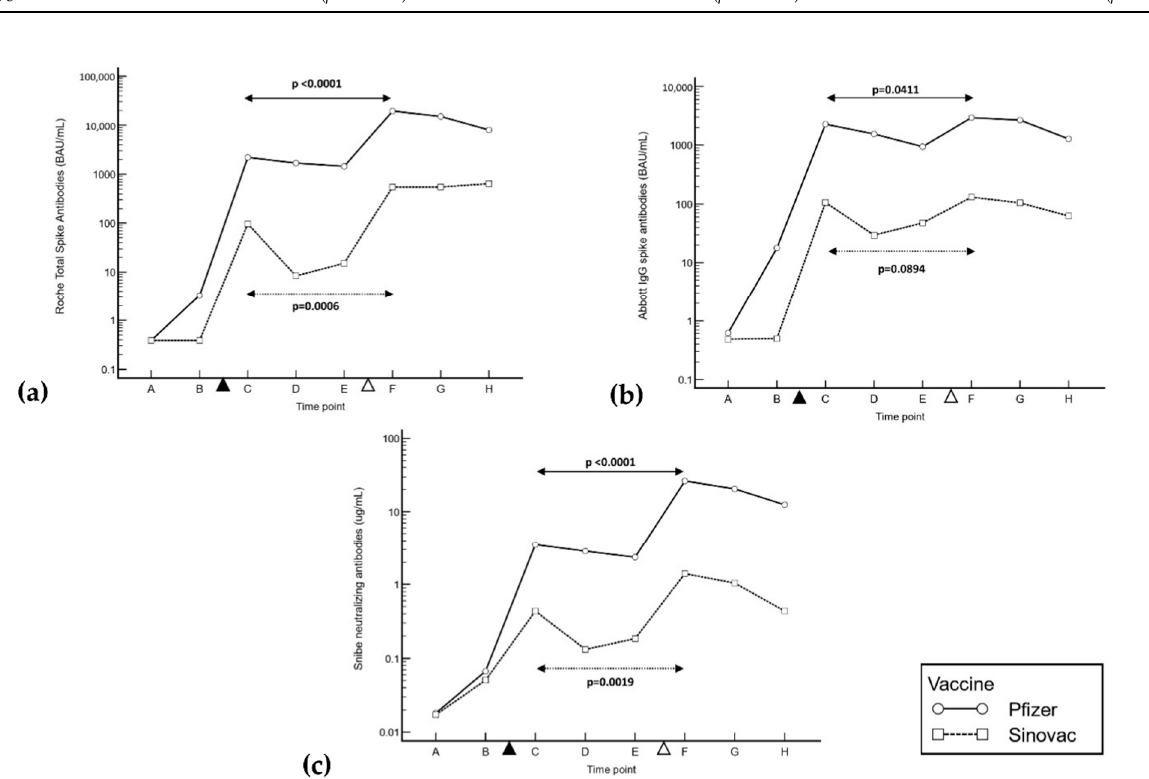
Figure 1. ( a ) Roche total, ( b ) Abbott IgG and ( c ) Snibe neutralizing antibody responses to 3 doses of BNT162b2 vs. CoronaVac inactivated virus vaccines at the same time points. Time points are represented by A, baseline; B, 10 days post-dose 1; C, 20 days post-dose 2; D, 40 days post-dose 2; E, 60 days post-dose 2; F, 20–30 days post-dose 3; G, 50–70 days post-dose 3; H, 90 days post-dose 3. The black triangle represents dose 2, and the white triangle represents dose 3. Antibody levels are expressed on a semi-logarithmic scale. Mann–Whitney U test two-tailed probability between peak antibody levels is displayed for each group.